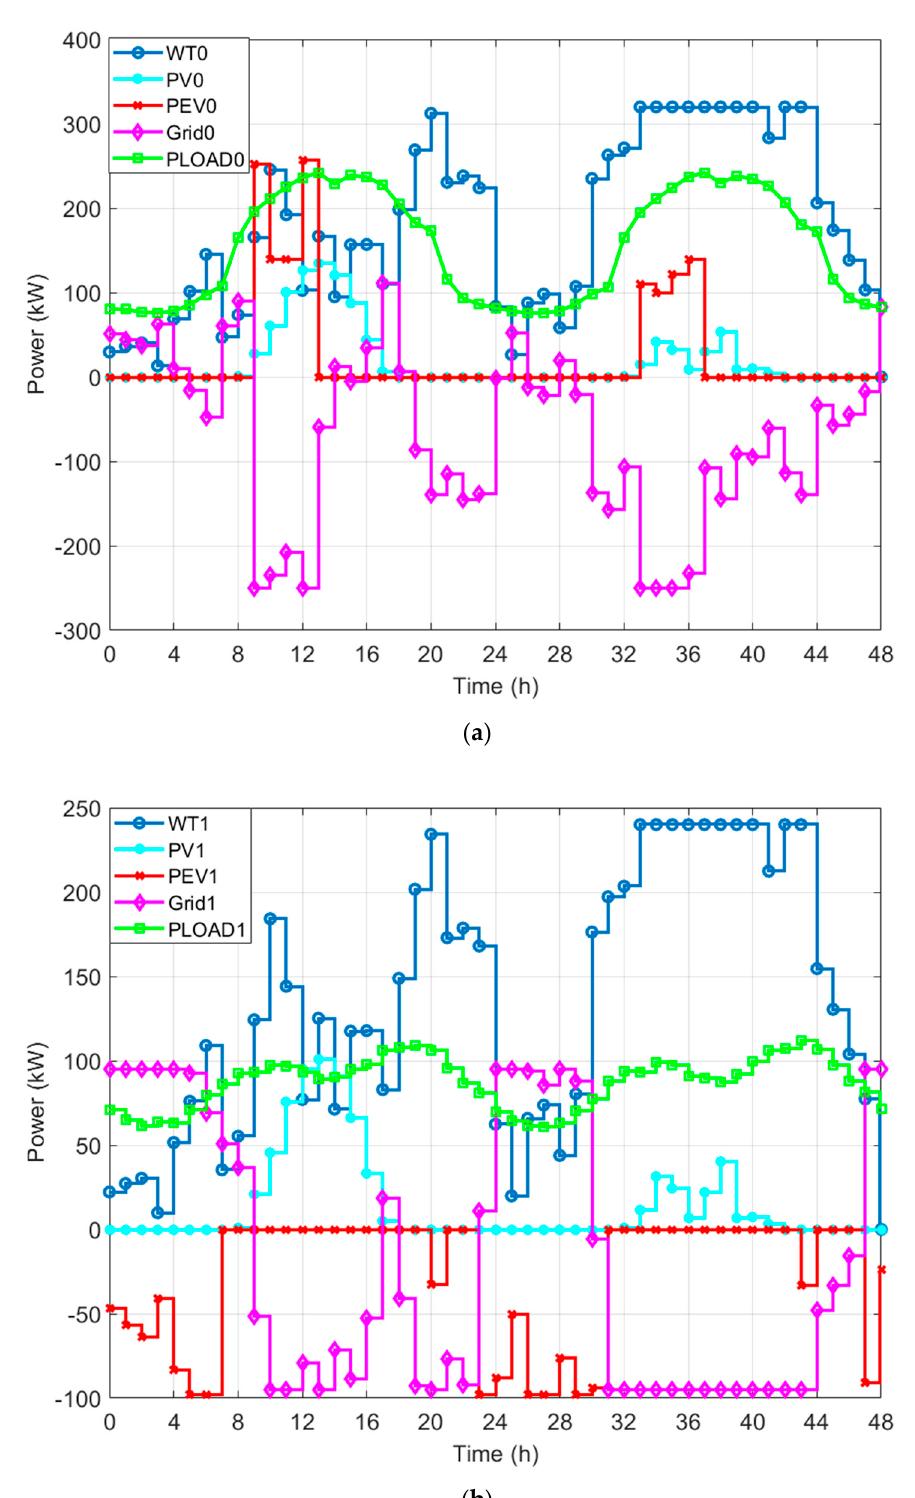
Figure 6. Dispatching results in Case 1: ( a ) Dispatching profiles of RMG1; ( b ) Dispatching profiles of OBMG.